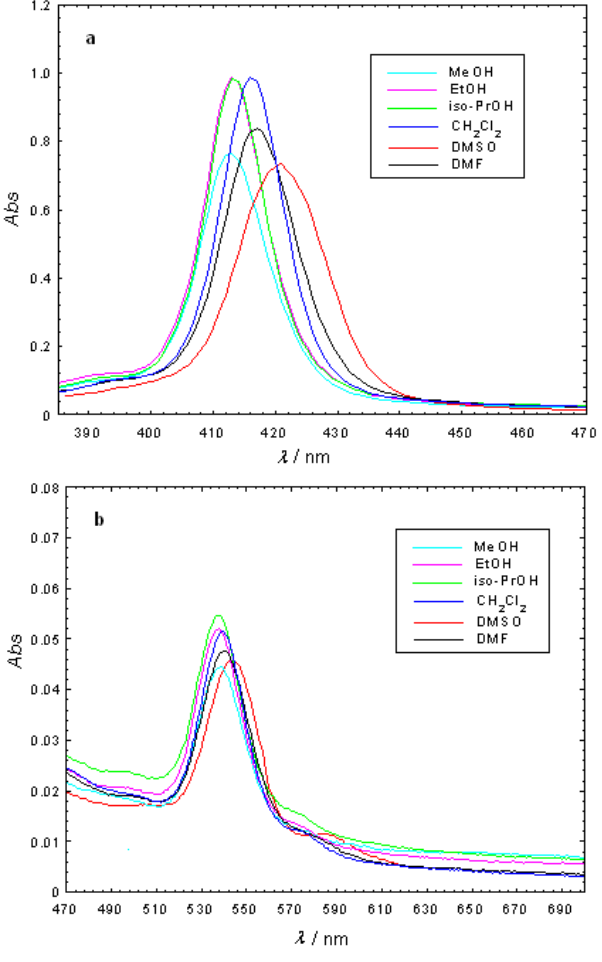
Figure 3. Absorption spectra of 2.5 × 10 -6 M Cu(II)TCMPOH Soret band; b -Q